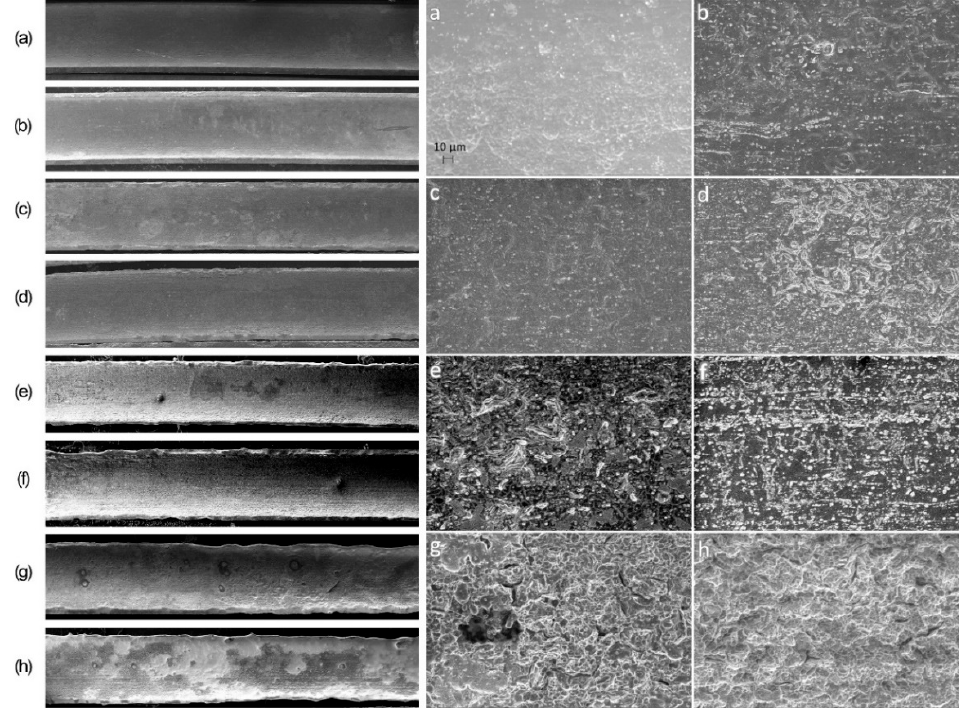
Figure 4. Typical morphology of dog bone specimens after immersion for ( a ) 1 day; ( b ) 2 days; ( c ) 3 d; ( d ) 4 days; ( e ) 6 days; ( f ) 8 days; ( g ) 9 days; and ( h ) 11 days. SEM Magnification: 30× (images on left) and 400× (images on right). J. Manuf. Mater. Process. 2017 , 1 , 8